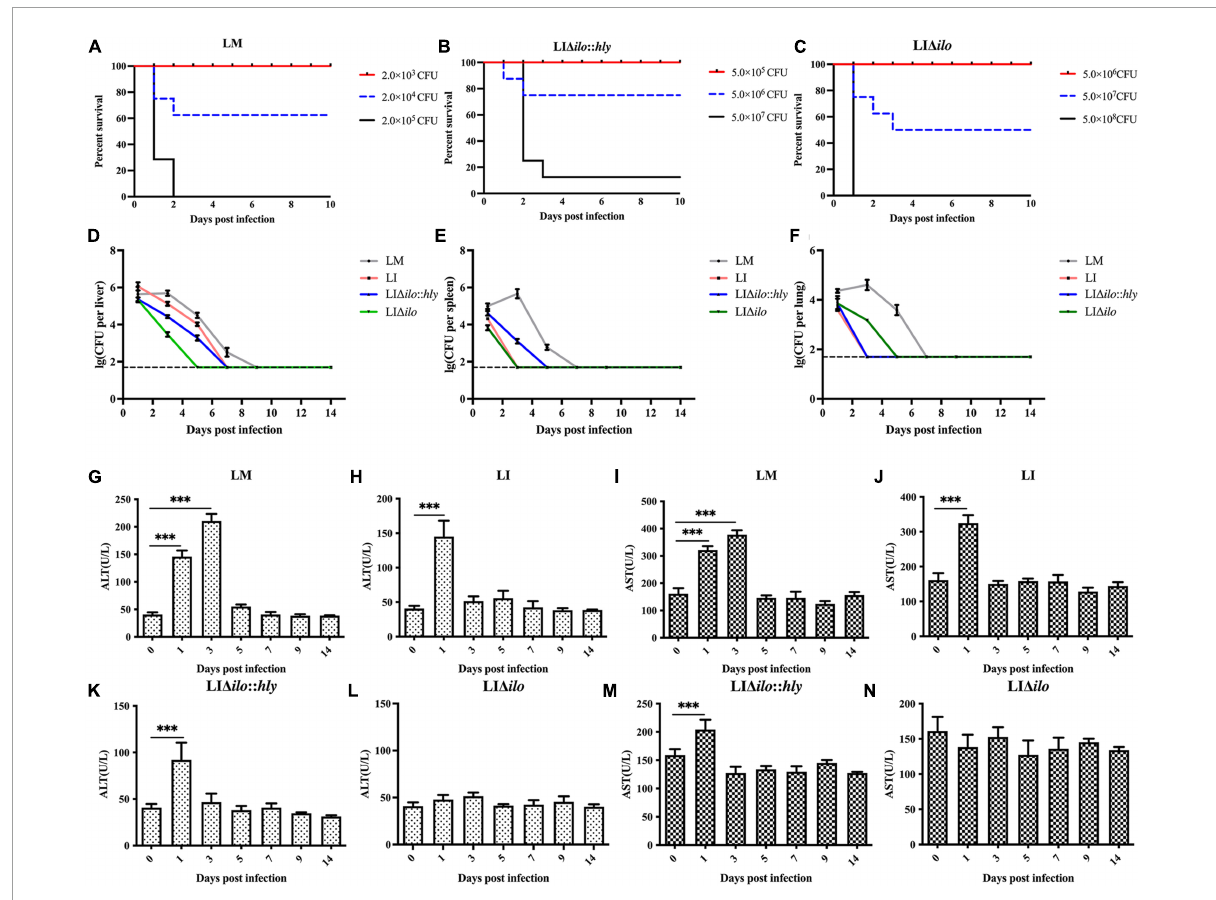
FIGURE4 In vivo biosafety evaluation of each strain. Survival curves of C57BL/6 mice intravenously inoculated of Listeria monocytogenes (LM) (A) , LI (cid:49) ilo : hly (B) , and LI (cid:49) ilo (C) ; Eight mice per group in this experiment. The bacteria load in liver (D) , spleen (E) , and lung (F) of mice intravenously inoculated of each strain; each point represents the mean ± SEM for a group of three mice from one independent experiment. Mice serum ALT levels after inoculation of LM (G) , LI (H) , LI (cid:49) ilo : hly (K) , and LI (cid:49) ilo (L) , and mice serum AST levels after inoculation of LI (J) , LM (I) , LI (cid:49) ilo : hly (M) , and LI (cid:49) ilo (N) . Results are expressed as means ± SEM per group, ∗∗∗ P < 0.005. The experiments were performed with biological